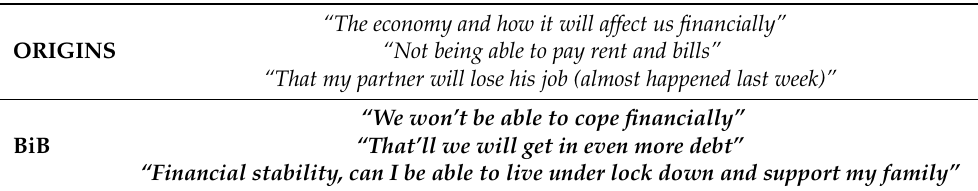
Table 1. Financial concerns: Sample